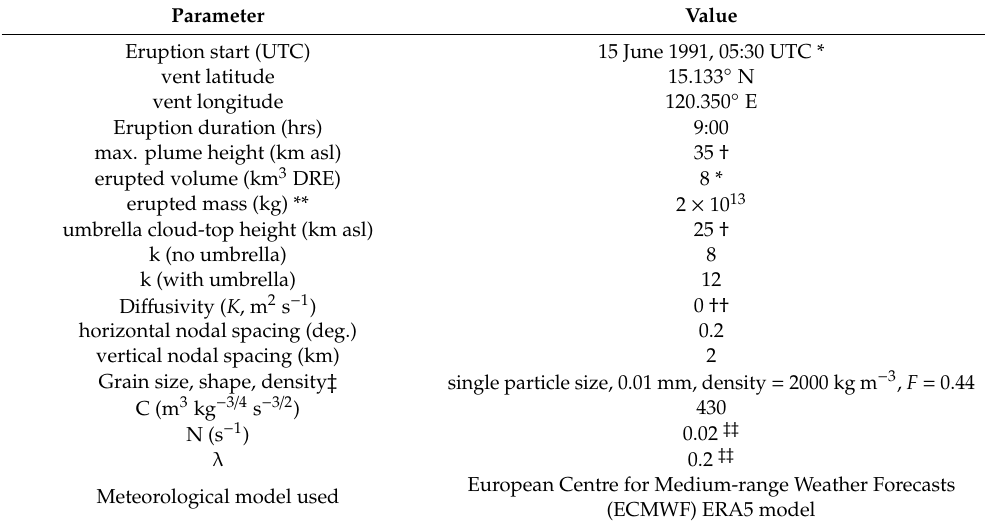
Table 1. Inputs to Ash3d simulations of